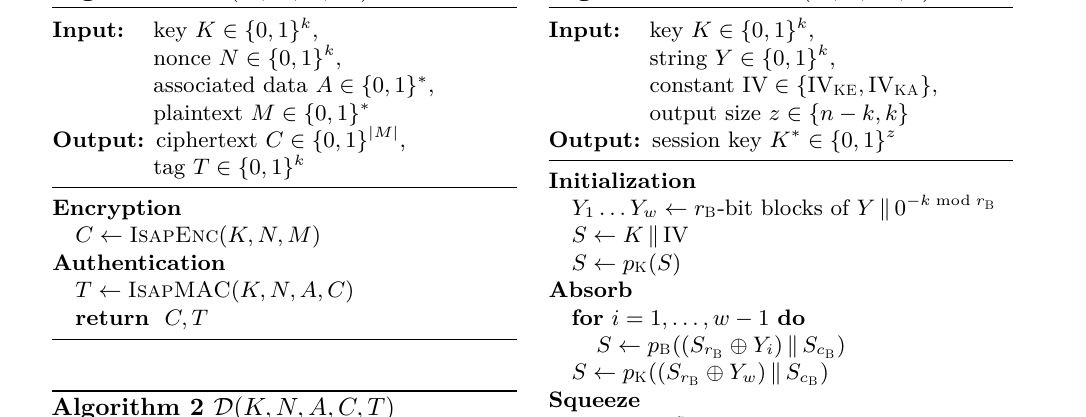
Algorithm 2 D ( K, N, A, C, T )